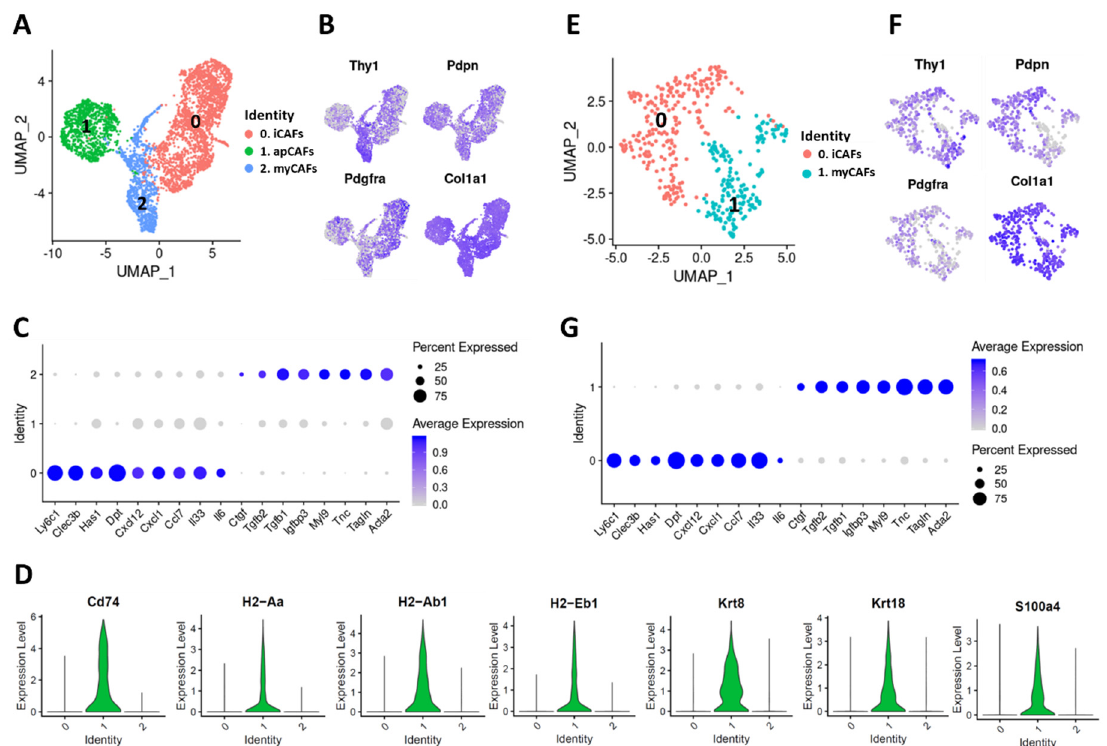
Figure 4. Characterization of CAF subtypes in murine PDAC. ( A ) UMAP plot showing various CAF subtypes identified in PDAC tumors from KPC mice. ( B ) Expression of commonly used CAF markers in KPC-derived PDAC CAFs. ( C ) Dot plot showing the expression of selected markers of Ly6c1 high CAFs (iCAFs) and α -SMA high CAFs (myCAFs) in KPC-derived PDAC CAFs. Dot size represents the fraction of cells expressing a specific marker in a particular cluster and intensity of color indicates the average expression in that cluster. ( D ) Violin plots showing the expression of Cd74 high CAF (apCAFs) markers in KPC-derived CAFs (cluster identities on X-axis). ( E ) CAF subtypes identified in subcutaneous mT3 tumors. ( F ) Expression of commonly used CAF markers in mT3 tumor-derived CAFs. ( G ) Dot plot showing the expression of selected iCAF and myCAF markers in mT3-derived CAFs.